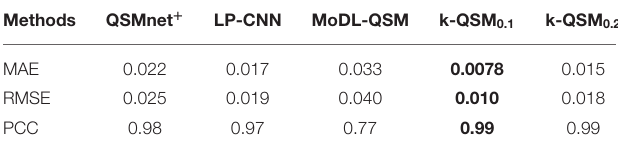
TABLE 3 | Mean absolute error (MAE), root mean square error (RMSE), and Pearson’s correlation coefficient (PCC) of line profiles outlined in Figure 6 with respect to calculation of susceptibility through multiple orientation sampling (COSMOS).